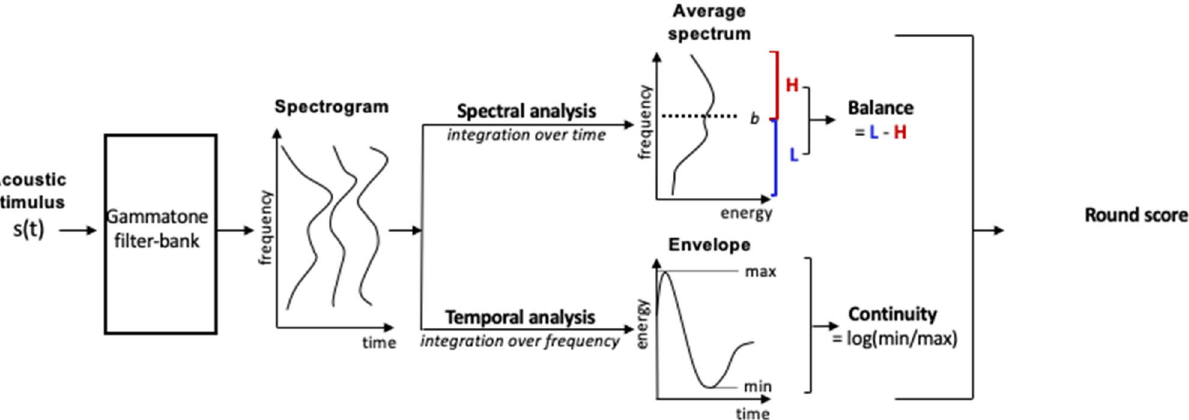
Figure 1. Schematic representation of the phenomenological model used for predicting round (over spiky) score based on the properties of each stimulus s (t) for each experiment. First, a spectrogram is generated thanks to a classical gammatone filter-bank inspired from auditory filtering 52 . Then, two independent analyses are applied. Spectral analysis (top pipeline) provides the Balance index defined as the difference between summed energy in low and high spectral components around a boundary b (Eq. 1). Temporal analysis (bottom pipeline) provides the Continuity index based on the ratio between the minimum and maximum energy through time within the corresponding stimulus (Eq. 2). Finally, the round (over spiky) score is linearly predicted from the combination of Balance and Continuity values. For more details, see "Methods" and Supplementary